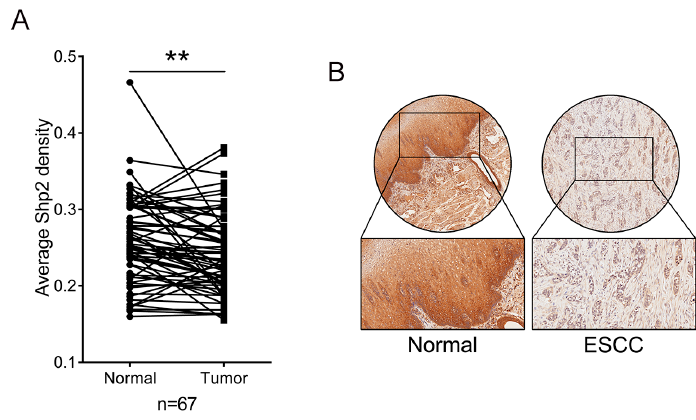
Figure 1. Cont. Figure 1.